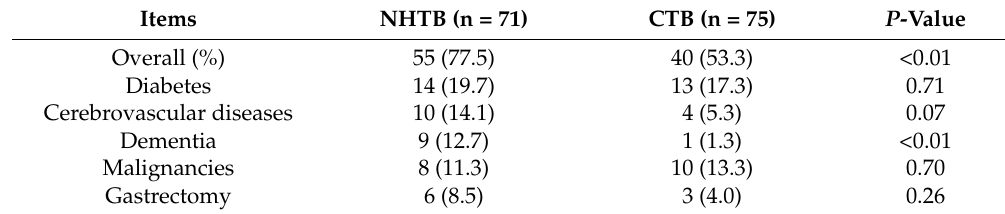
Table 3. Comorbid conditions in patients with NHTB and CTB.